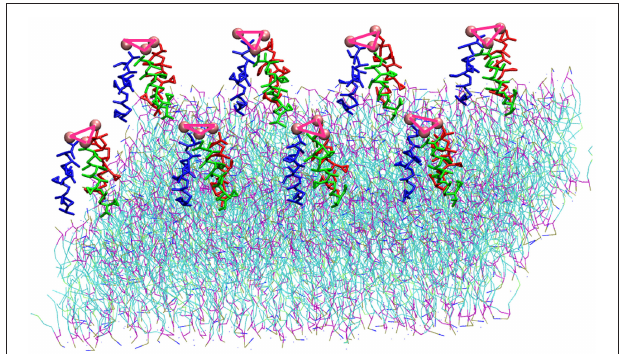
FIGURE 1 | Representation of the simulation box: 8 TFP monomers interacting with a POPC phospholipid bilayer in an aqueous environment. Each TFP monomer is composed by three 20-long fusion peptides chain colored in red, blue and green. The beads shown in Van der Waals representation are GLY residues added to bond three peptide chains. Note that the water is not shown so that the details of the TFP monomers and the lipid membrane can be